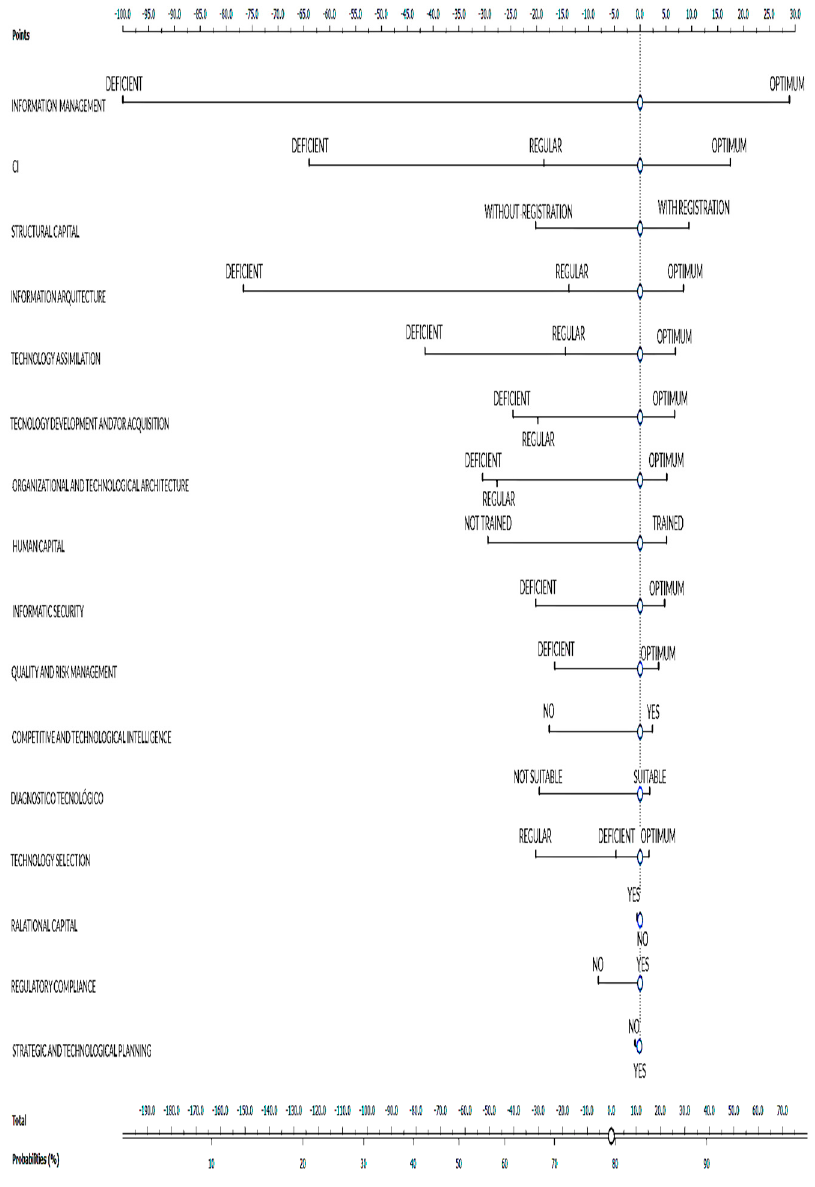
Figure 4. Nomogram that indicates the values of the variables to reach the objective determined by the class.